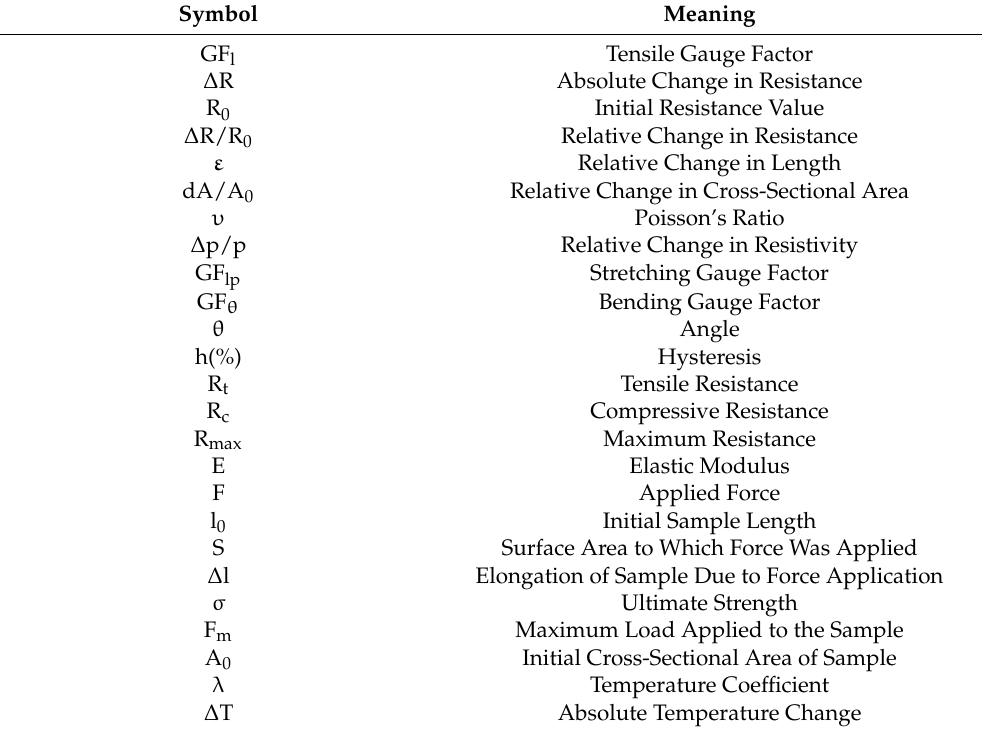
Table 2 presents the meanings of symbols used in electrical and mechanical calculations. Table 2. Nomenclature